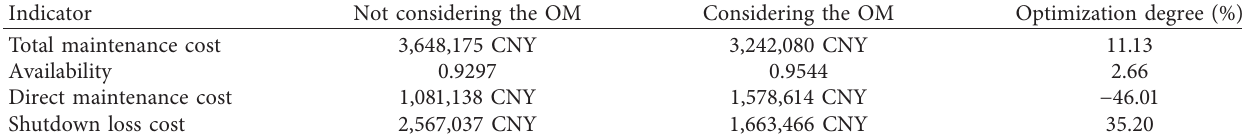
Table 5: The comparison before and after considering the OM strategy on some important indicators.